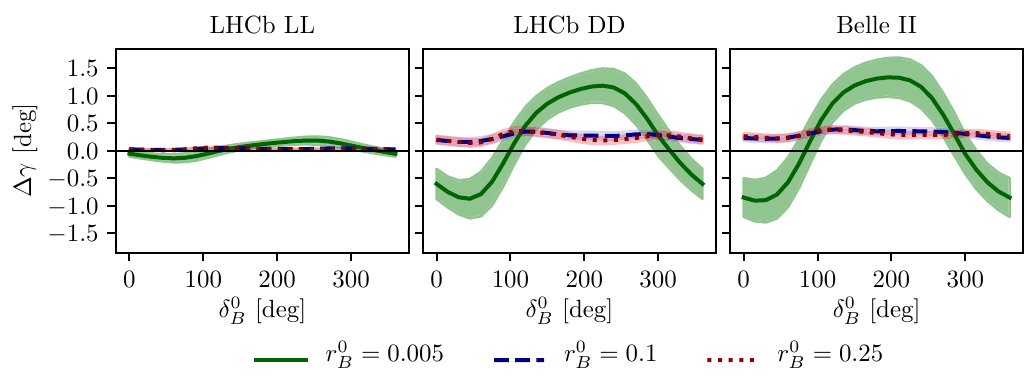
Figure 5 . The bias ∆ γ as a function of input δ B for (left) the LL LHCb category, (centre) the DD LHCb category, and (right) Belle II. The bias is calculated for γ = 75 ◦ and (green line) r B = 0 . 005, (blue, dashed line) r B = 0 . 1, and (red, dotted line) r B = 0 . 25. The shaded region shows the estimated 1 σ uncertainty